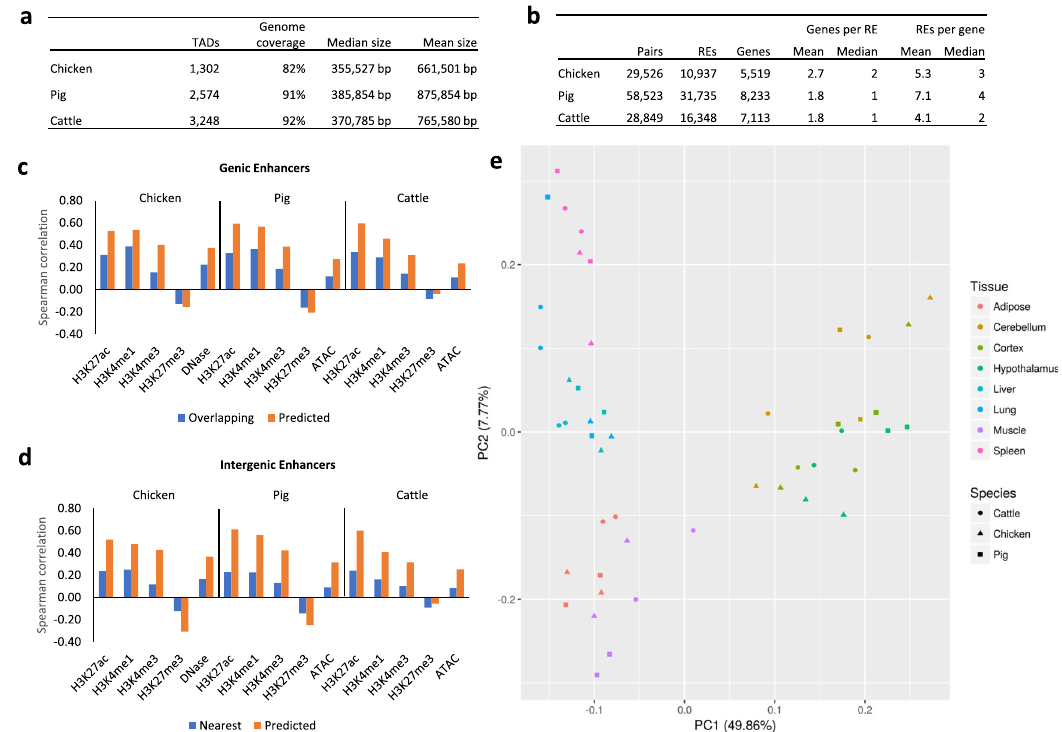
Fig. 4 Target gene prediction of regulatory elements. a Topologically associated domains (TADs) predicted by CTCF ChIP-seq data. b The number of predicted RE – gene pairs, the total number of REs and genes in at least one pair, and the mean and median number of predicted genes per RE and REs per gene. c Spearman rank correlation of normalized read depth in each genic RE with the expression of the gene it overlaps (blue bars) and the expression of the genes predicted as targets (orange bars). d Spearman rank correlation of normalized read depth in each intergenic RE with the expression of the nearest gene (blue bars) and the expression of the genes predicted as targets (orange bars). e Principal component plot of the normalized read depth of H3K27ac of intergenic REs predicted to target genes with one-to-one orthologs across all three